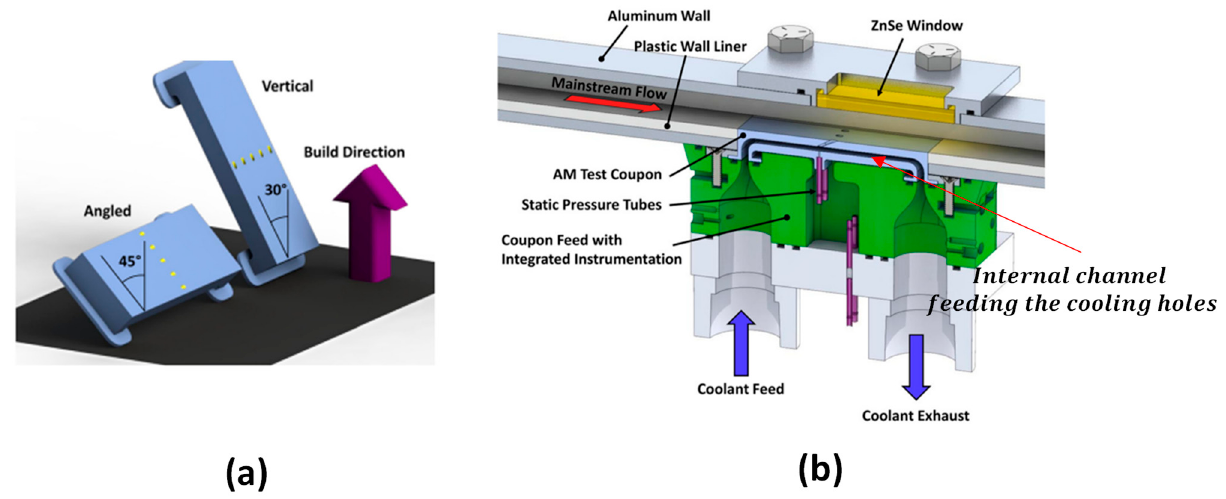
Figure 3. ( a ) Build orientations for coupons, and ( b ) cut-section view of the test rig and the additively